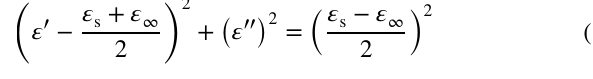
Figure 5e, f reflects the reflection loss of CF@1T/2H MoS and CF@2H MoS with the 5% filler loading. When 2 2 the thickness is 2.7 mm, the R value of CF@1T/2H MoS Lmin 2 can reach −43 dB at 13.4 GHz only with 5% filler loading. Comparatively, the CF@2H MoS with 5% filler loading is 2 almost impossible to achieve electromagnetic